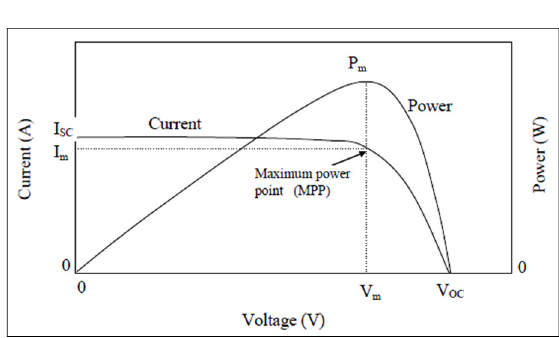
Fig. 2. Characteristics of solar cell